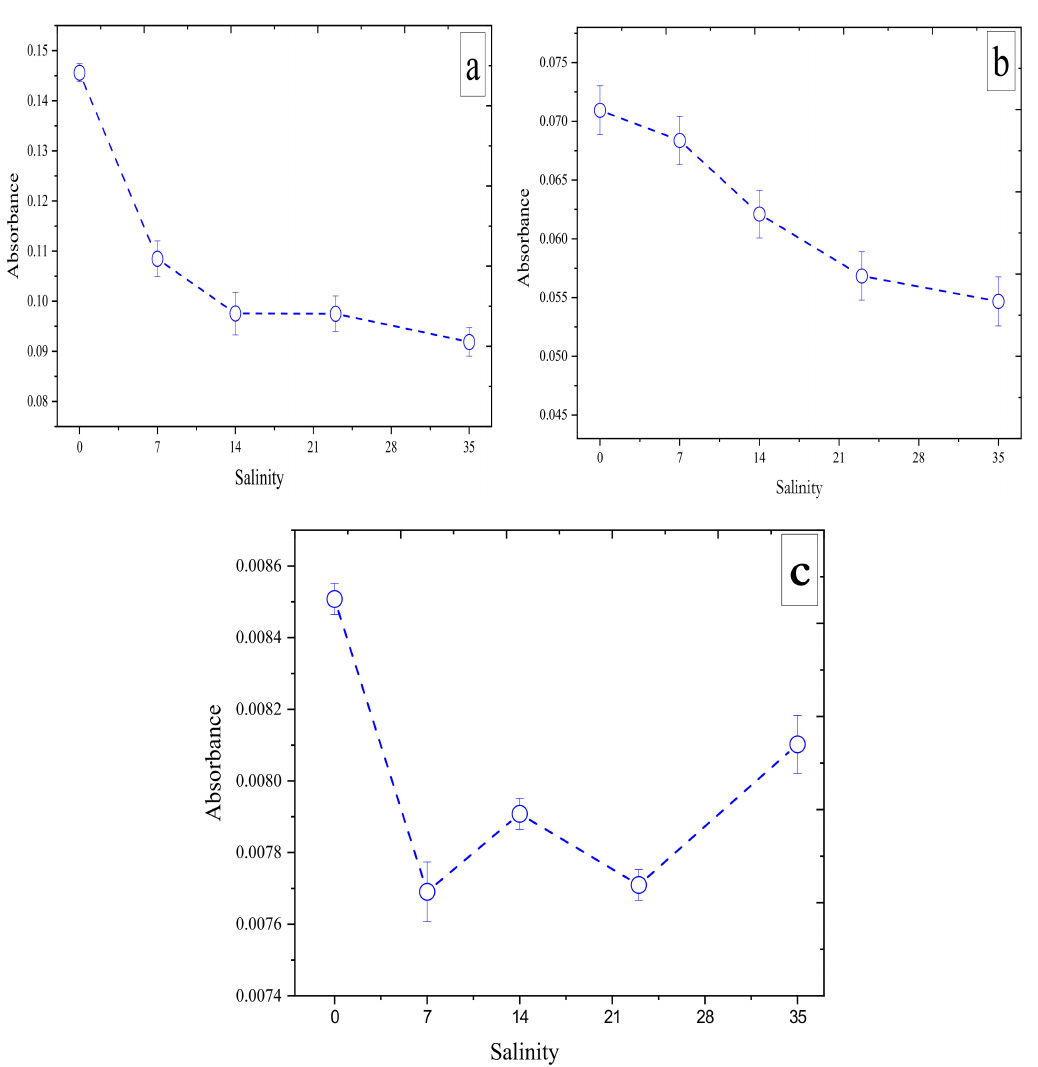
Figure 5. Effects of salinity (S = 0, 7, 14, 23, and 35) on the absorbances of a ( a ) 5 µ M NO 3 −